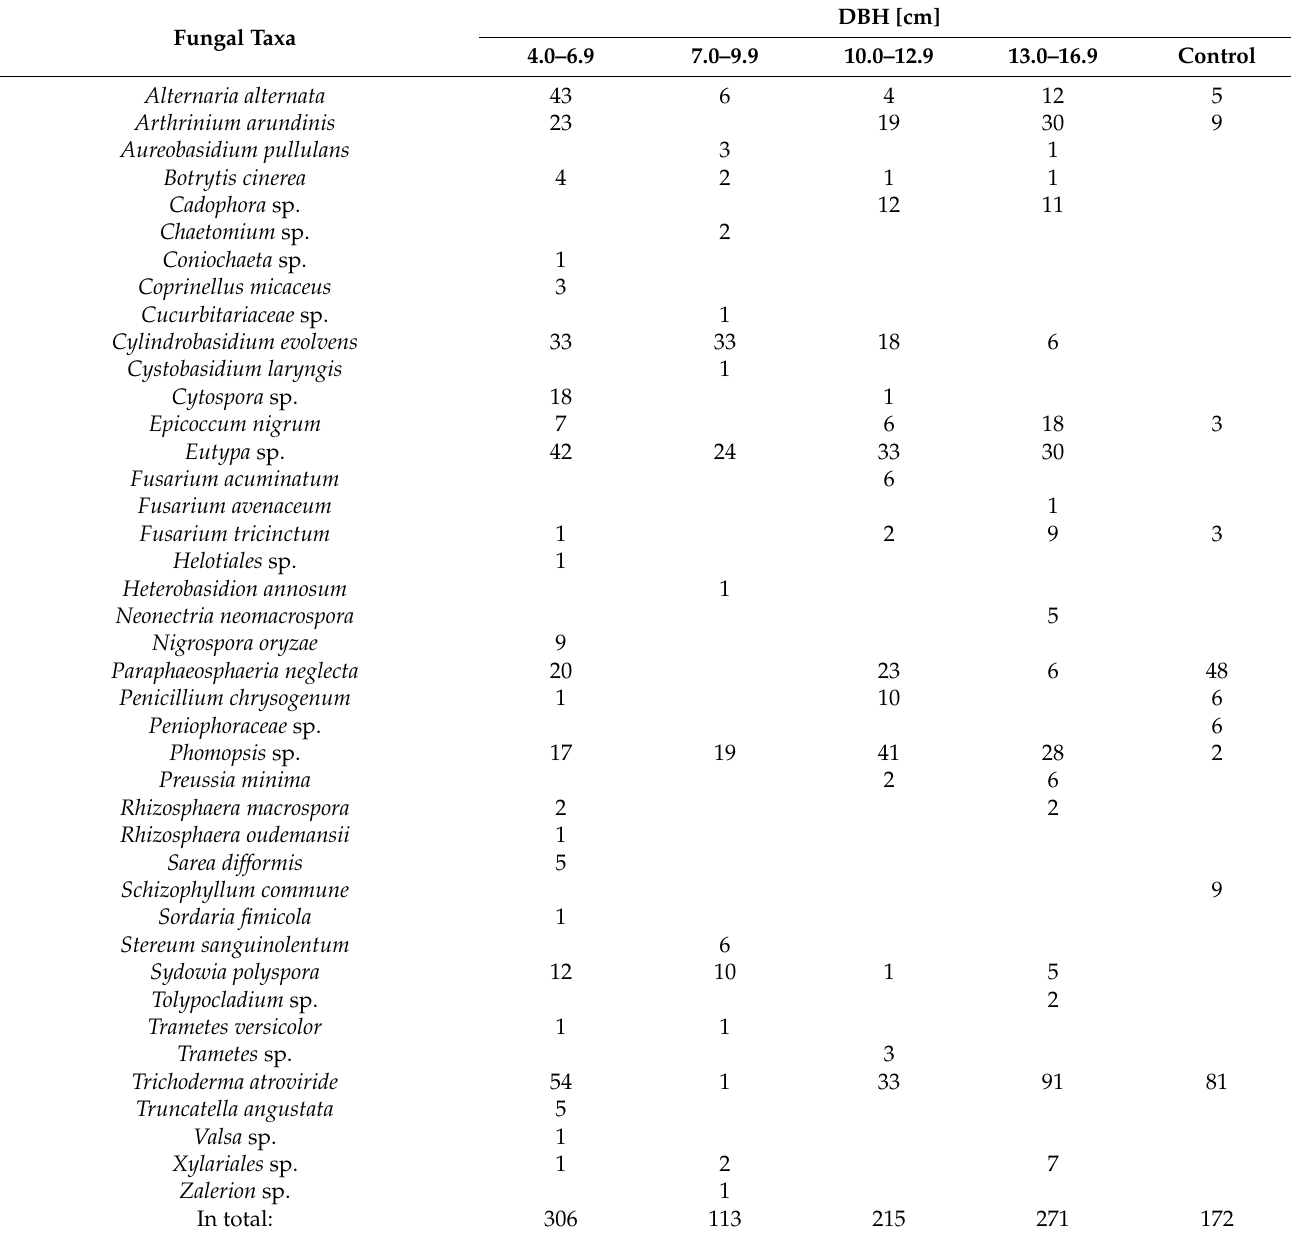
When analyzing wounds on fir trunks in terms of their DBH, it was found that the largest number of colonies occurs in thinner trees (DBH 4.0–6.9 cm). In their case, 306 colonies belonging to 25 taxa were obtained. In trees thicker than 7.0 cm, the number of colonies ranged from 113 to 271, with 32 taxa. The fungi of the genus Eutypa and Phomopsis had the highest share (Table 4). Table 4. The number of isolated fungi colonies inhabiting wounds depending on the DBH of bark-stripped firs. Fungal